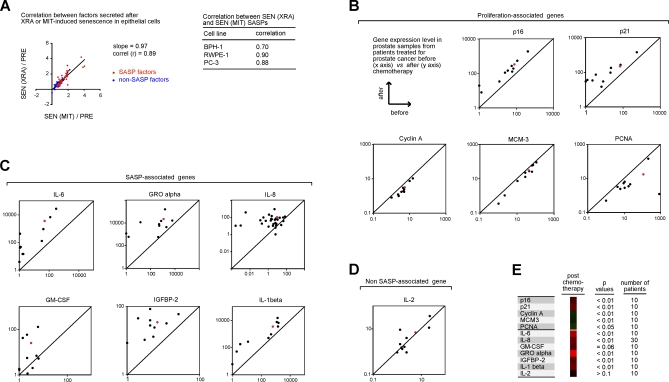
Chemotherapy-Induced SASP in Culture and In Vivo(A) Overall correlation between XRA and mitoxantrone (MIT)-induced SASPs for all three prostate epithelial cancer cell lines (BPH-1, RWPE-1, and PC-3). Correlations for the individual cell lines are given in the table to the right. The senescence inducer (XRA or MIT) is given in parentheses.(B–E) Human tumor cells were isolated from biopsies obtained from the same patient before MIT chemotherapy and from prostate tissue following prostatectomy after MIT chemotherapy. Laser captured cells were analyzed by quantitative RT-PCR for the mRNAs encoding the indicated proteins, as described in Materials and Methods and Text S1. The results are displayed on a log10 scale indicating the values before (horizontal or x-axis) compared to after (vertical or y-axis) chemotherapy (top left panel in [B]). Each black dot in (B, C, and D) represents the results obtained from a single patient. The average values for all patients before versus after chemotherapy are indicated by a red dot (B–D); these values are also represented as a heat map in (E).(B) Values for mRNAs encoding proteins associated with senescence (p16 and p21) and proliferation (cyclin A, MCM-3, and PCNA).(C) Values for mRNAs encoding SASP-associated proteins (IL-6, IL-8, GM-CSF, GRO-α, IGFBP-2, and IL-1β).(D) Value for an mRNA encoding a non-SASP–associated protein (IL-2).(E) Averages for the values shown in (B–D). Overall p-values, determined by the Student t-test, and number of paired samples (or patients) analyzed for each mRNA are given to the right of the heat map. Signals higher than the prechemotherapy baseline are shown in red; signals below baseline are displayed in green.